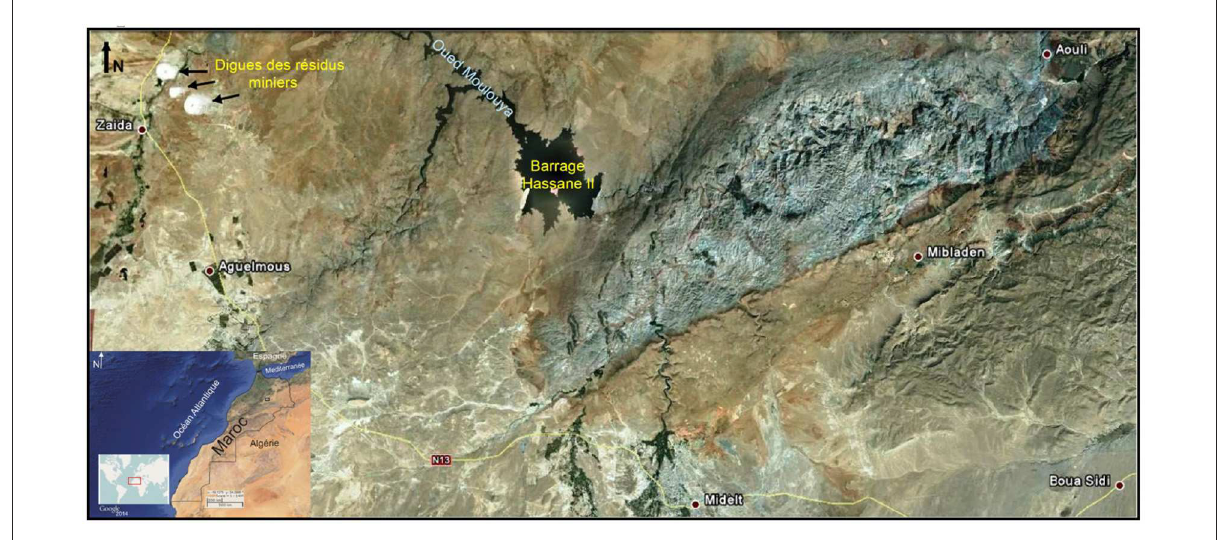
FIGURE6 The Mining district of Zeïda-Mibladen-Ahouli (image Google Earth,